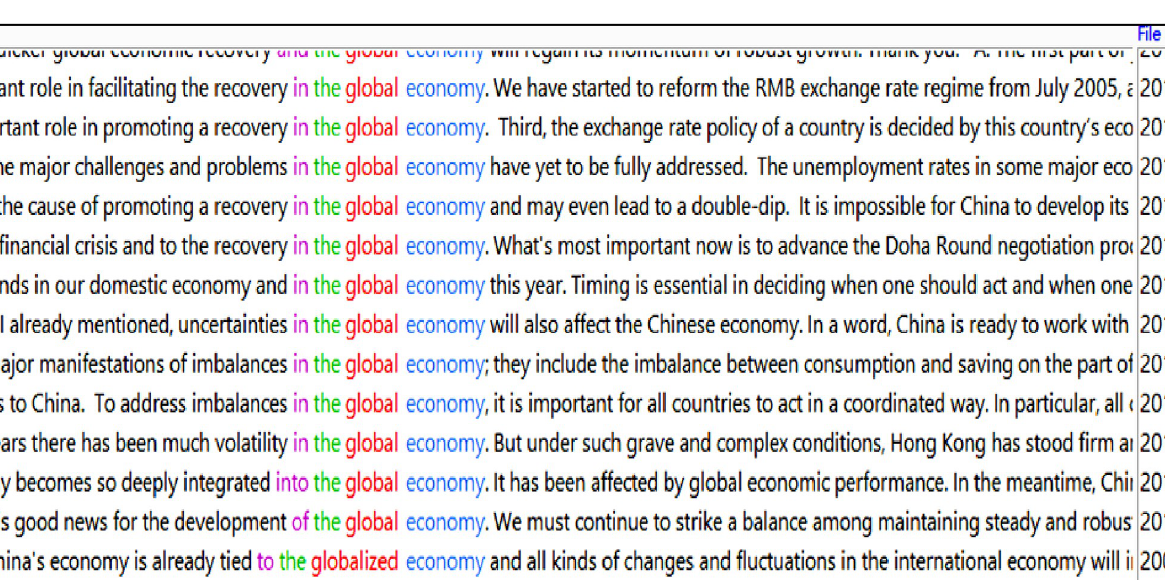
Fig 4. Concordance lines relating to ‘global economy’ and ‘globalised